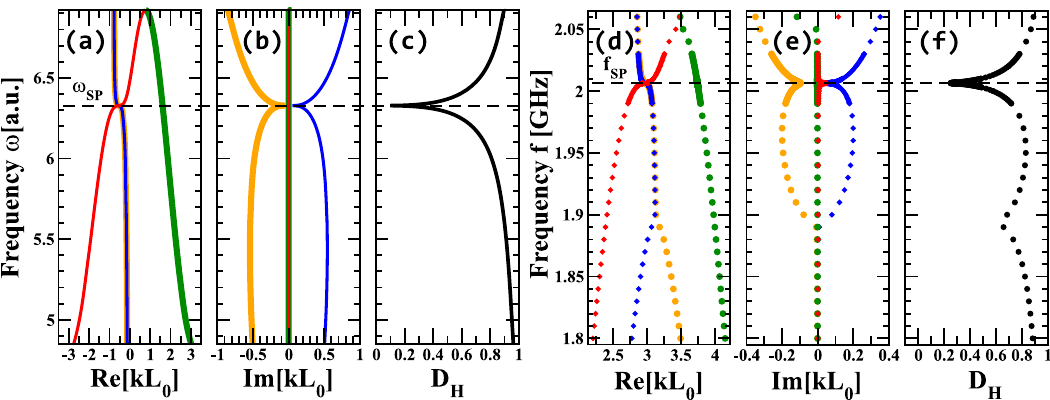
Fig. 7 Non-resonant exceptional point degeneracy coalescence at stationary point frequency in CMT and microstrip models. Frequency vs a real and b imaginary parts of the wavenumber for each of the four Bloch modes associated with the transfer matrix (see Eq. 26) of the Coupled Mode Theory (CMT) model (see Eq. 22). c Frequency vs coalescence parameter for the CMT model. d – f The same as ( a – c ), but now for the microstrip waveguide of Fig. 1e. In a , b , d , e , red solid/dotted lines correspond to the slow propagating mode, blue solid/dotted lines correspond to the forward evanescent mode, orange solid/dotted lines correspond to the backward evanescent mode and green solid/dotted lines correspond to the backward fast propagating mode. The black horizontal dashed lined indicates the stationary in fl ection point